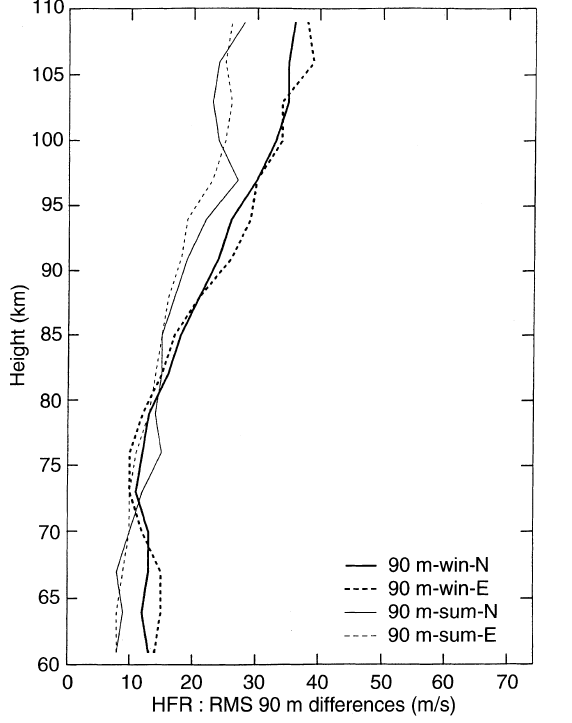
Fig. 8. HRDI mean relative 90 min di(cid:128)erences and estimated errors (cid:129)(cid:129)(cid:129) p (the latter scaled down by 2 ) for winter and summer Urbana passes, expressed in percent